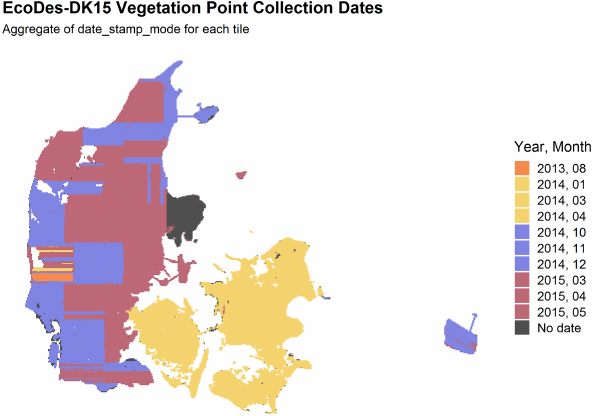
Figure 5. Distribution of the most common survey date for the vegetation points in each tile of the EcoDes-DK15 data set. The data shown are aggregated for each tile from date_stamp_mode de- scriptor. The figure highlights that while the majority of the vege- tation points are from 2014/15, the data set also includes a small amount of vegetation points from 2013 in western Jutland. Further- more, surveys were conducted in all seasons, with vegetation points originating in spring, summer, autumn and winter. Nonetheless, the majority of vegetation points come from the leaf-off season. Lastly, the date_stamp descriptors could not be derived for some regions as the GPS time was not provided in the point clouds. However, from auxiliary information we know that the surveys in the Mols Bjerge and Sønderborg areas were conducted in April–May 2015 and Oc- tober 2014,